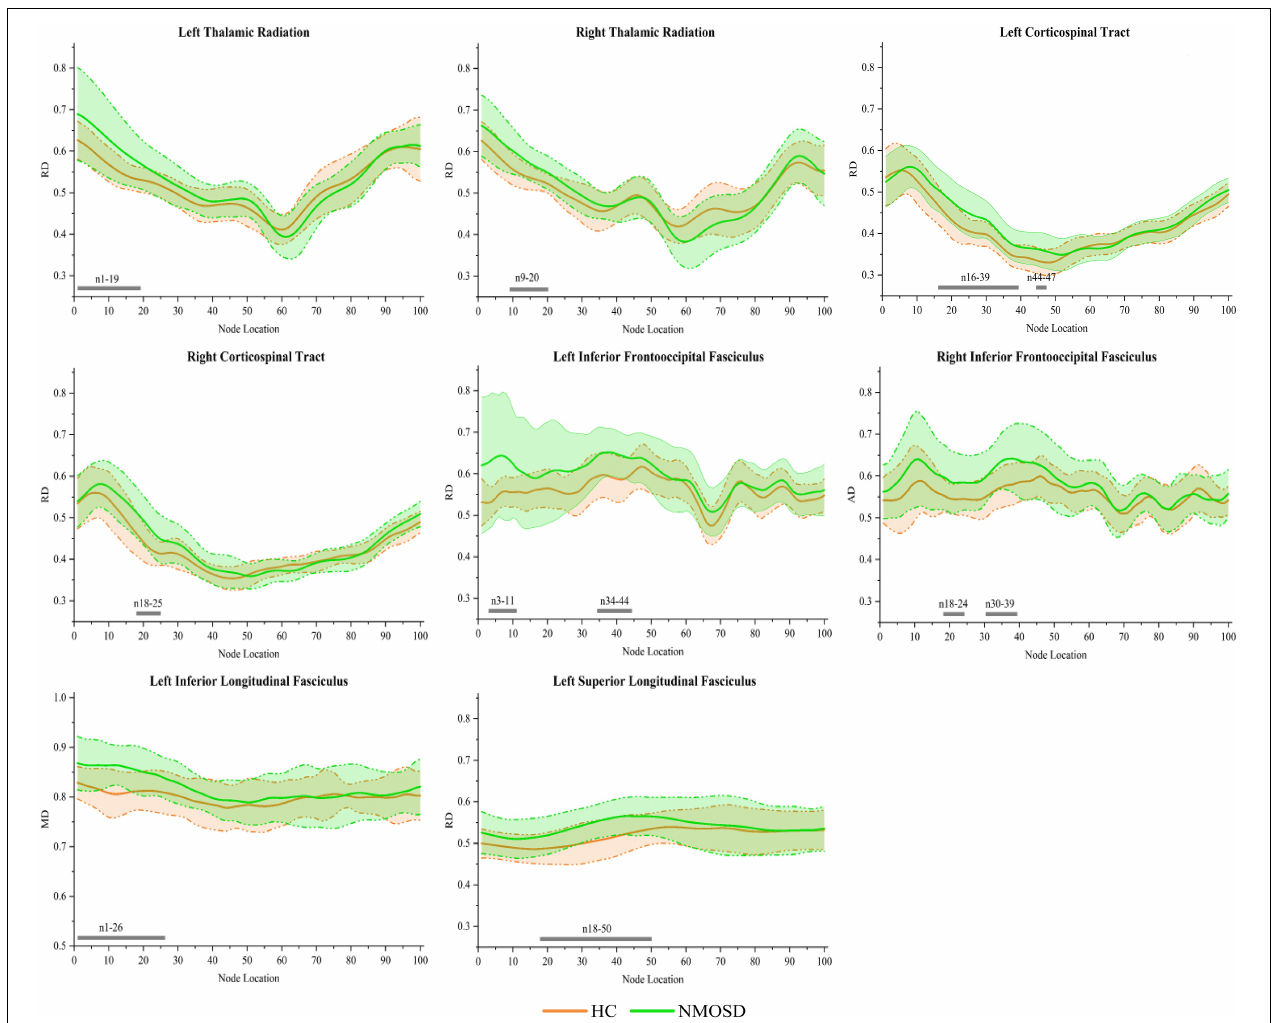
FIGURE 5 | Group differences in pointwise white matter (WM) fiber tracts of radial diffusivity (RD) between neuromyelitis optica spectrum disorder (NMOSD) and healthy control [HC; p < 0.05, false discovery rate (FDR) correction]. The green line represents the NMOSD group, and the orange line represents the HC group (solid lines for means and shaded regions for standard deviations). The gray bars at the bottom are the location of the fiber nodes with significant differences between the two groups.